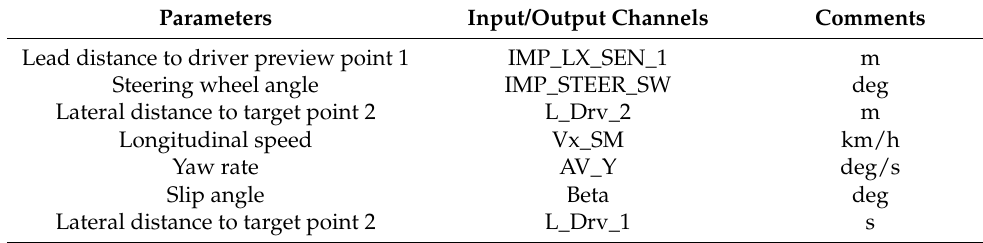
Table 3. Parameters for Carsim input and